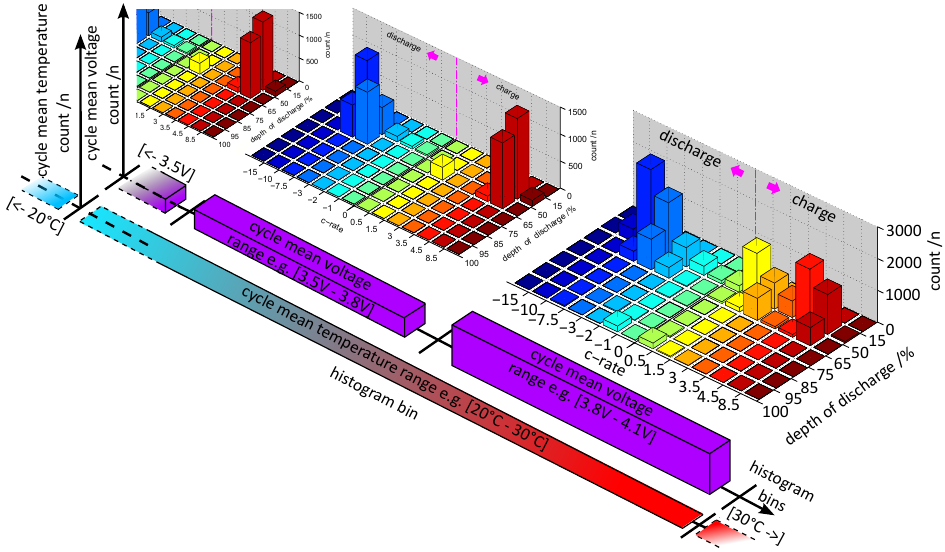
Figure 7. Exemplary illustration of “Nested” load